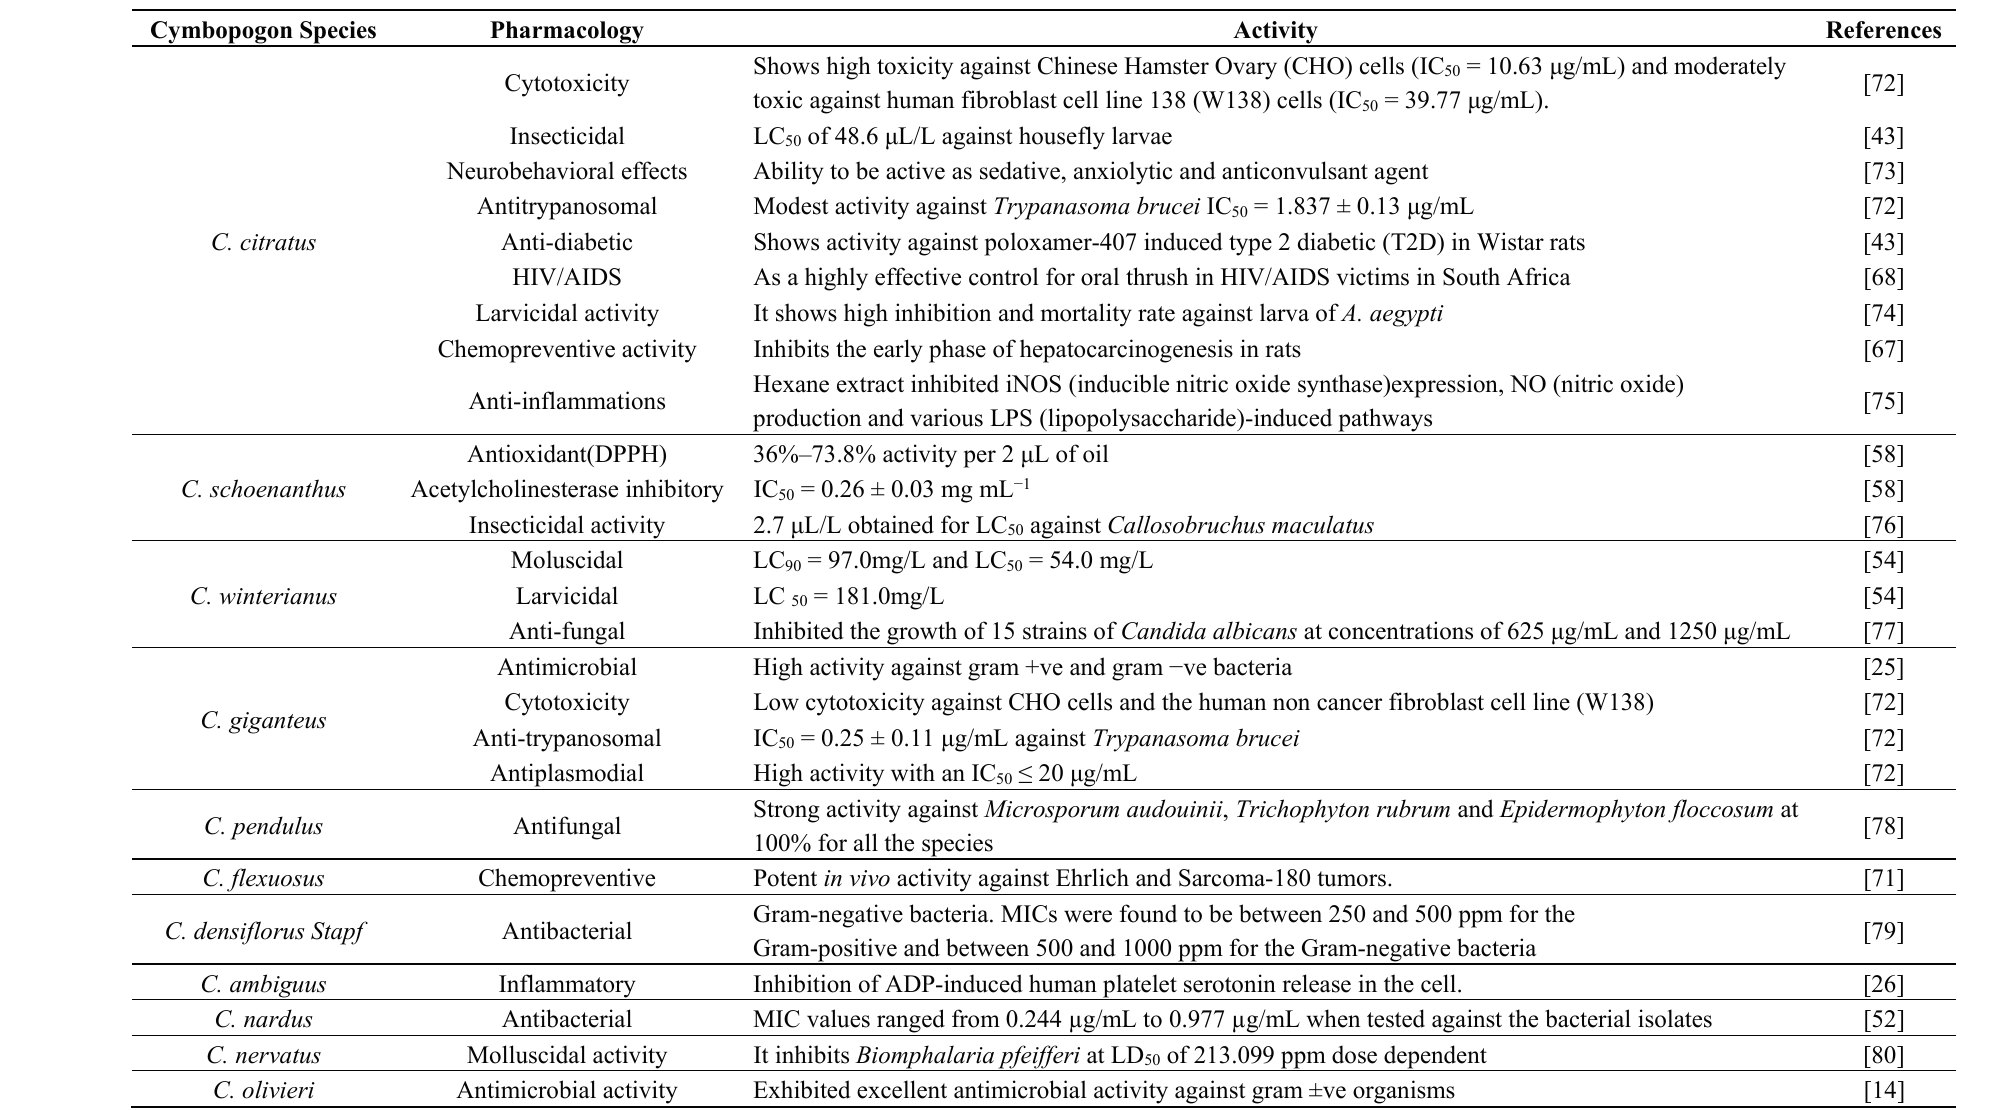
Table 3. Pharmacological evidence of some Cymbopogon